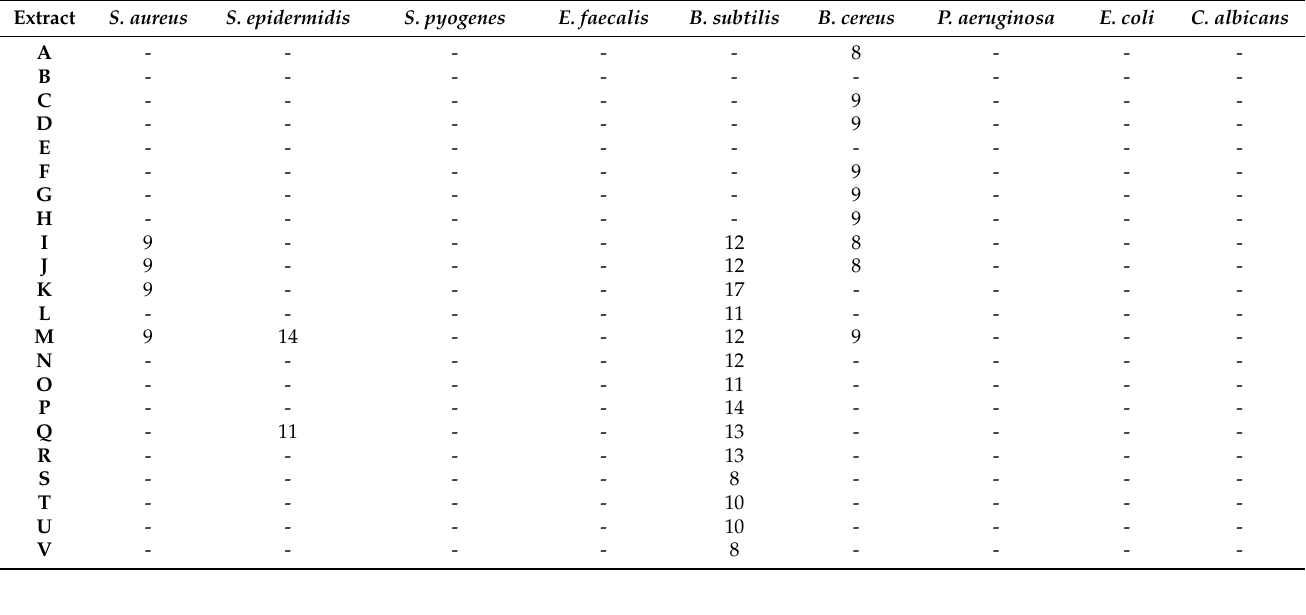
Table 5. Inhibition halos measured for the extracts (10 mg/mL) assayed with different strains. Extract